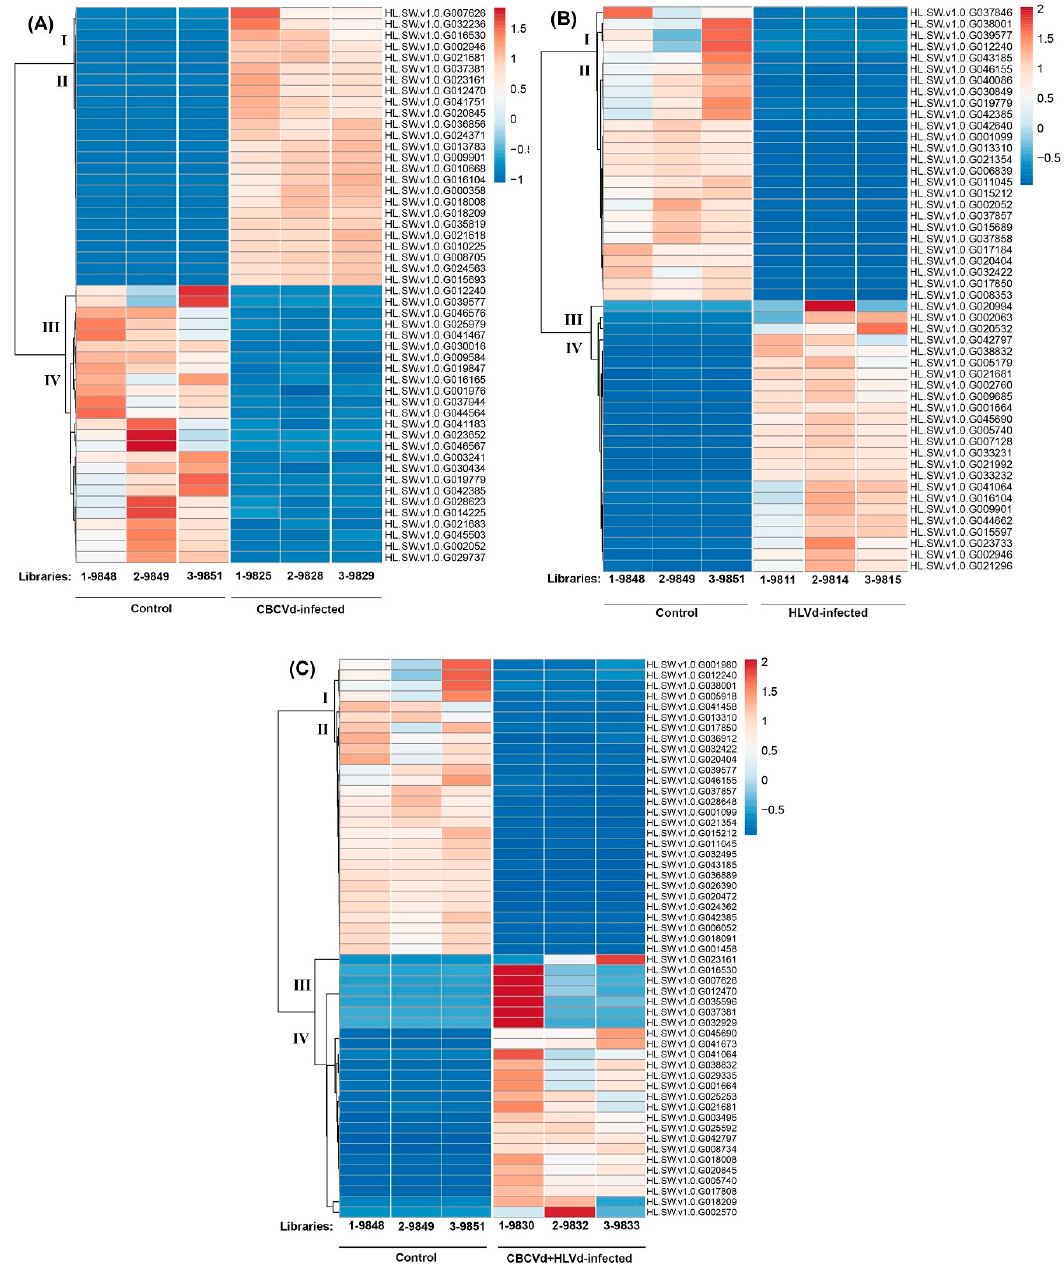
Figure 6. Heat map and complete linkage hierarchical clustering of differentially expressed genes in CBCVd infected ( A ), HLVd infected ( B ) and HLVd-CBCVd coinfected ( C ) hop. Colors on vertical represent the clustered genes based on gene expression, the horizontal line represents the single gene, and color of the line indicates the average gene expression in single and mixed CBCVd, HLVd infection. The signal ratios were shown in a blue-orange-red color scale, where red indicated high expression level and blue indicated low expression level.